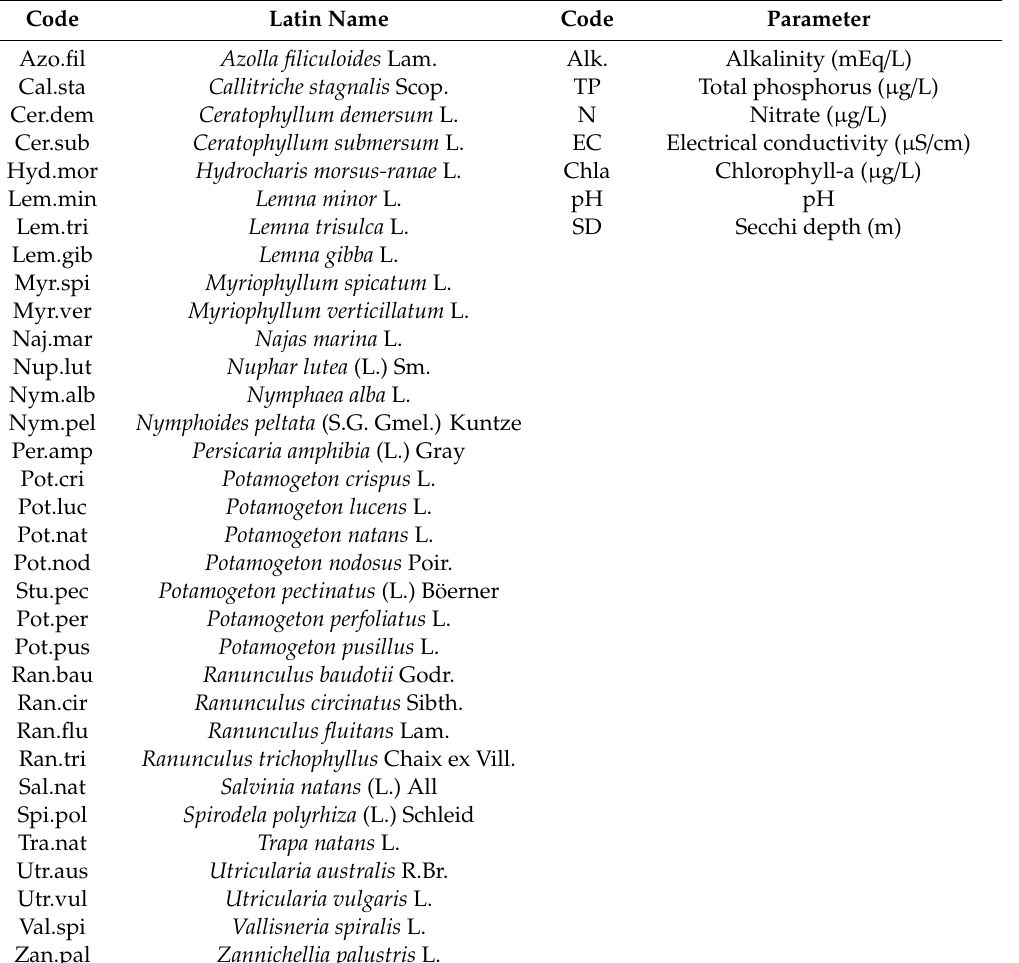
Table 2. List of aquatic macrophyte species and environmental variables considered in the present